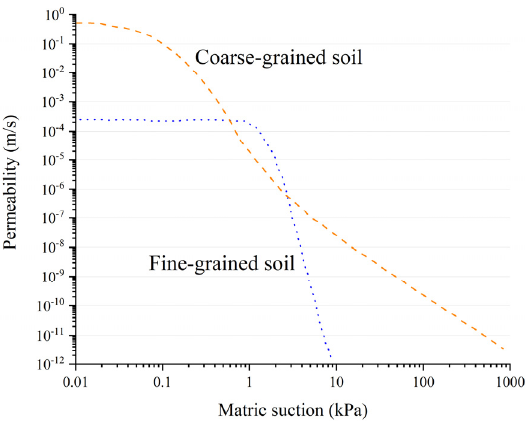
Figure 1. Permeability functions of different materials. Modified from [25].